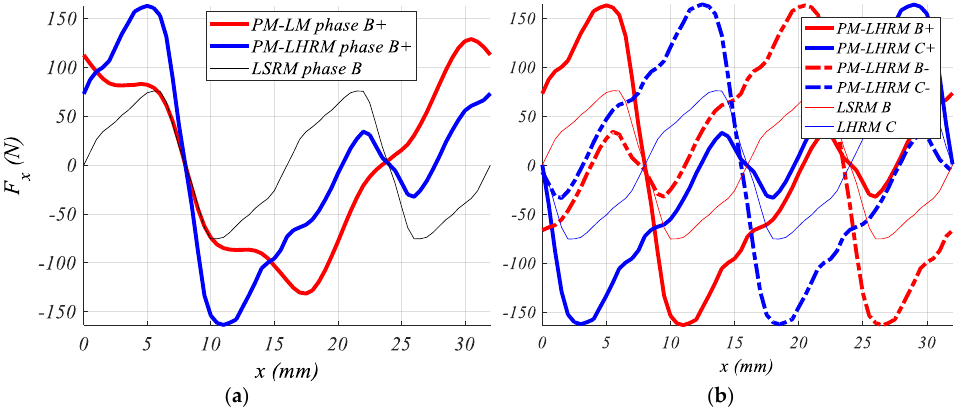
Figure 3. Propulsion force (N) vs. position (mm) simulation results at J = 10 A/mm 2 and shift = 0 mm. ( a ) Comparison of the 3 structures. ( b ) Comparison for the PM-LHRM and LSRM structure feeding phases B+, C+, B-, C-.